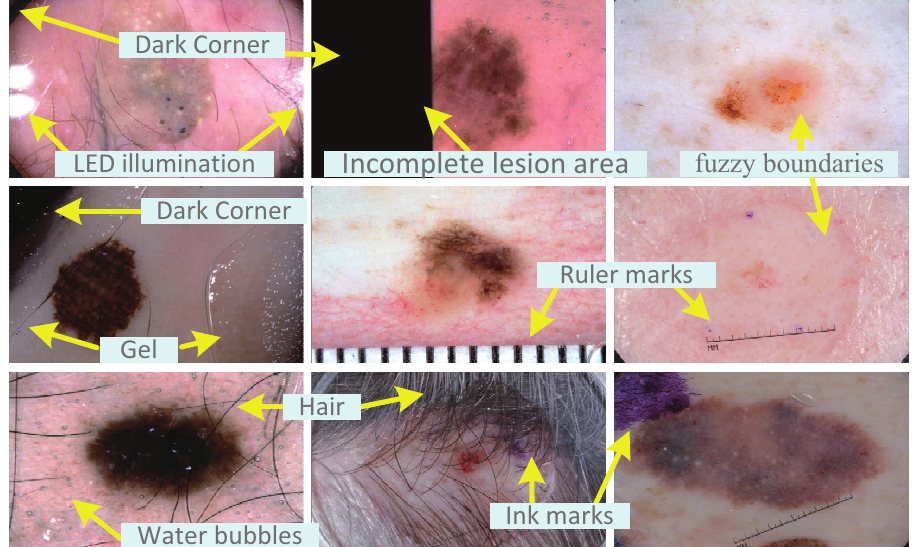
Figure 1. A typical pictorial presentation of the skin lesion images with different challenging for